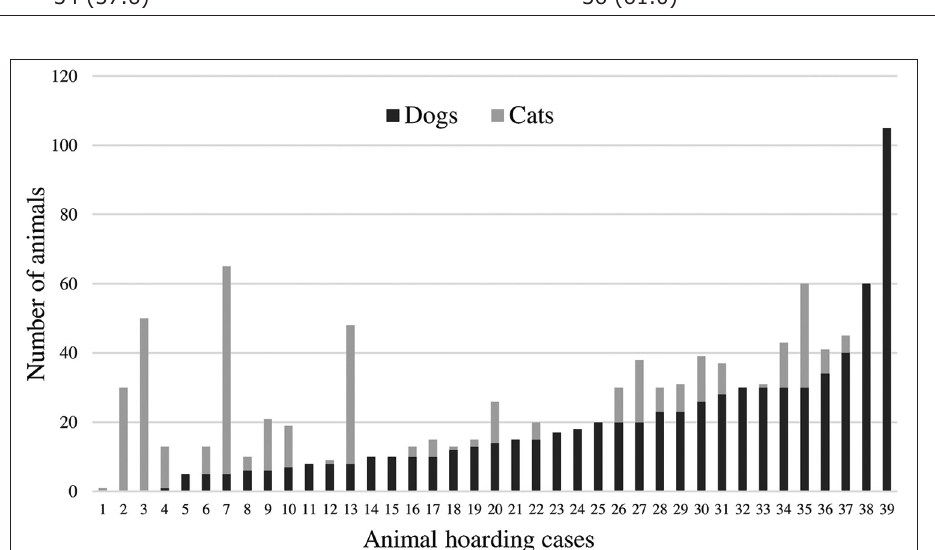
Figure-1: Distribution of dogs and cats per animal hoarding case in Curitiba, Brazil, from 2013 to 2015.